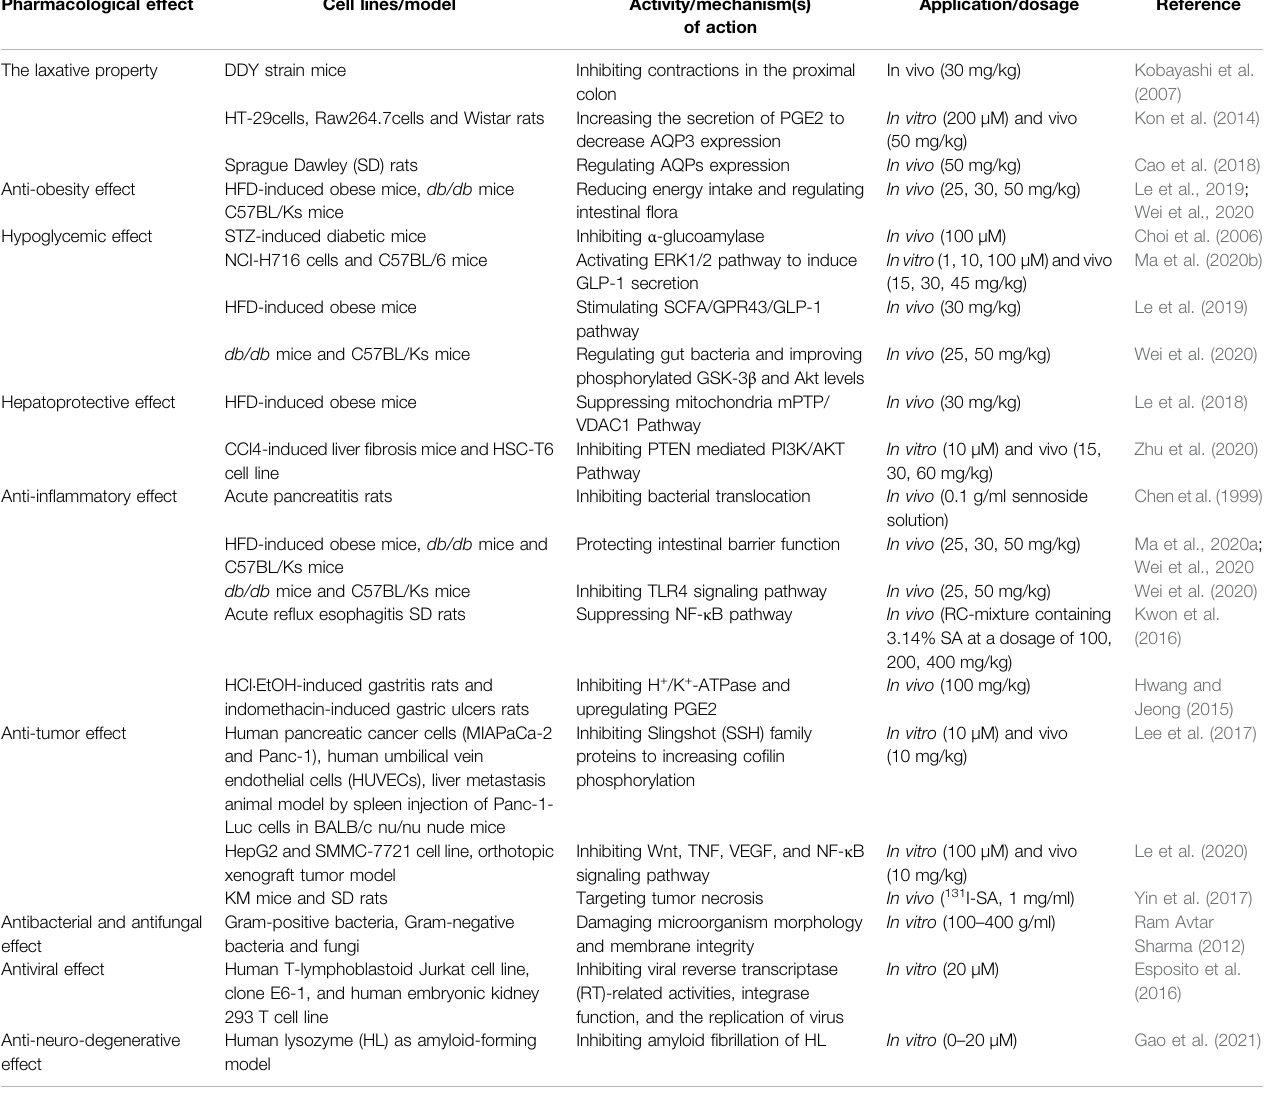
TABLE 1 | The pharmacological activities of sennoside